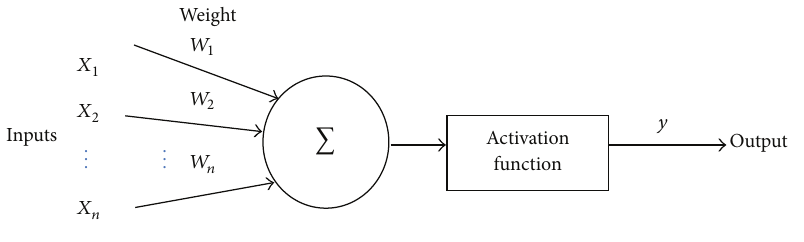
Figure 1: McCulloch and Pitts model of neuron.